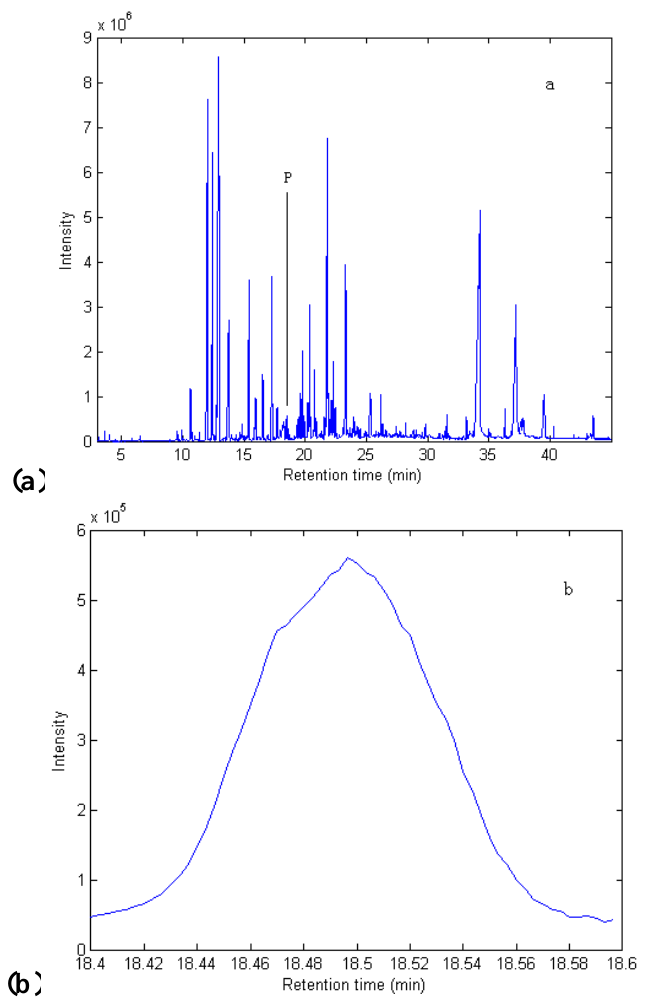
Figure 1. (a) TIC of essential oil of OFT. (b) TIC curve for overlapping peak P (within 18.4–18.6 min). (c) Resolved chromatograms for overlapping peak P containing components 1, 2 and